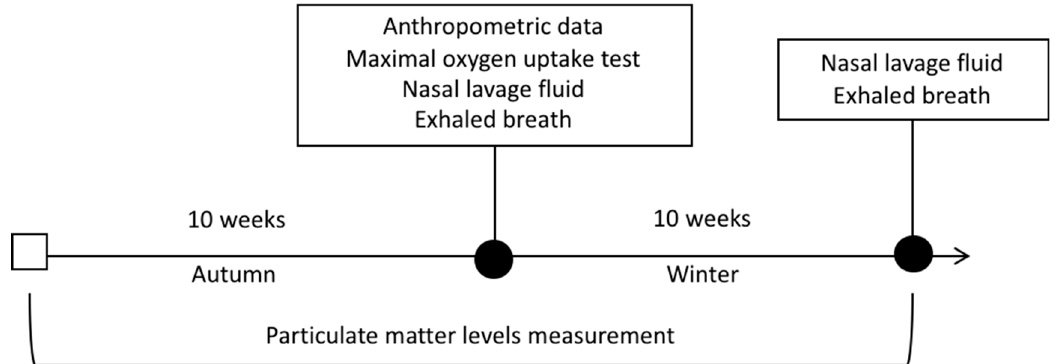
Figure 2. The experimental design.